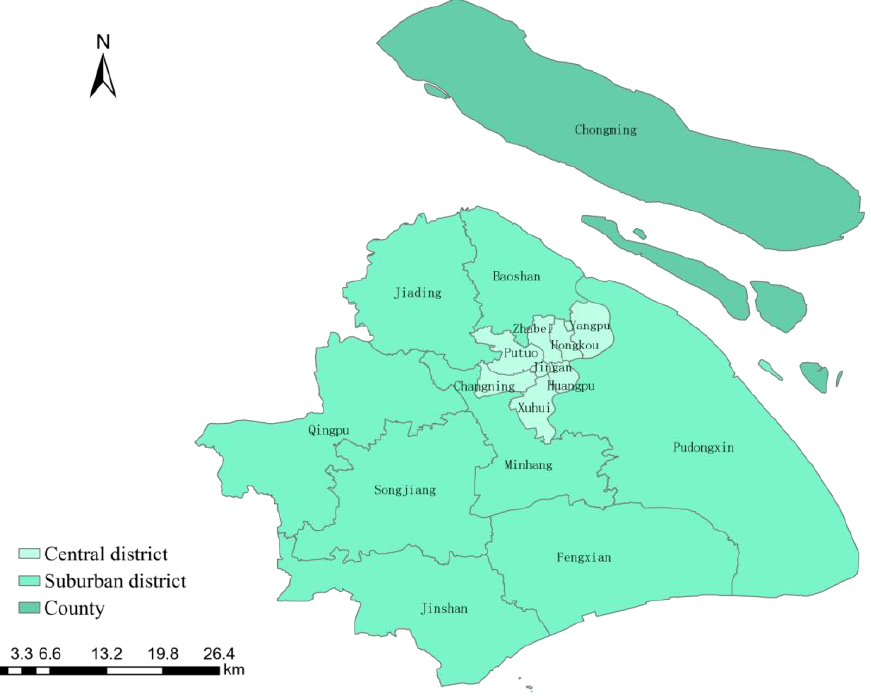
Figure 4. Distribution of central districts, suburban districts and a county in Shanghai.